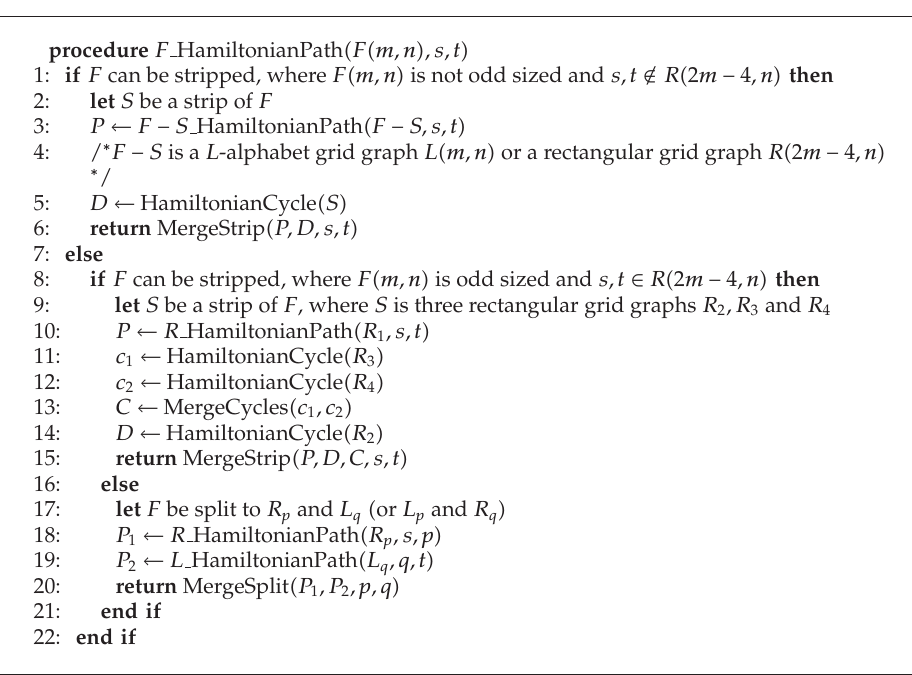
Algorithm 3: The Hamiltonian path algorithm for F -alphabet grid